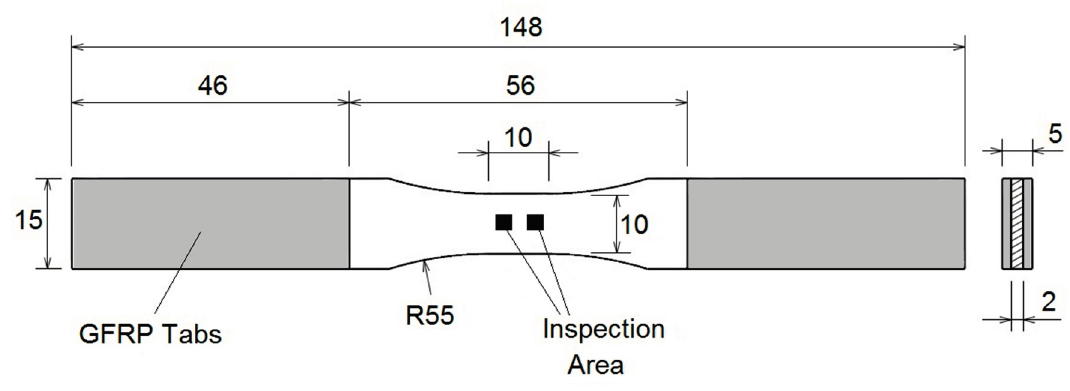
Figure 2. “Dog bone” geometry of the CFRP coupons used for tensile variable amplitude tests. Inspection area of one of the faces of the